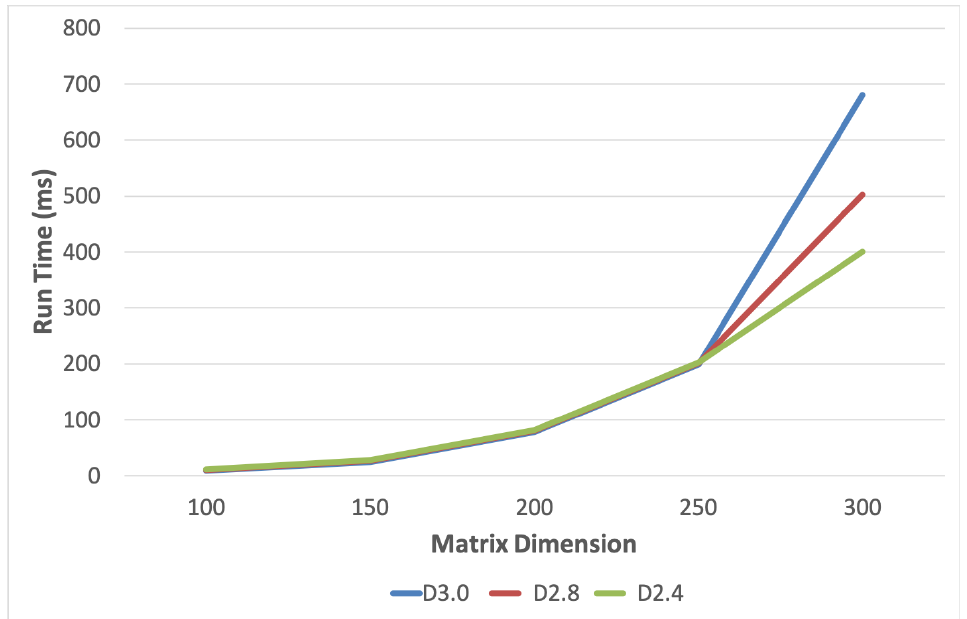
Figure 6. A detailed view of execution time (ms) for small matrix dimensions within estimated L1 cache